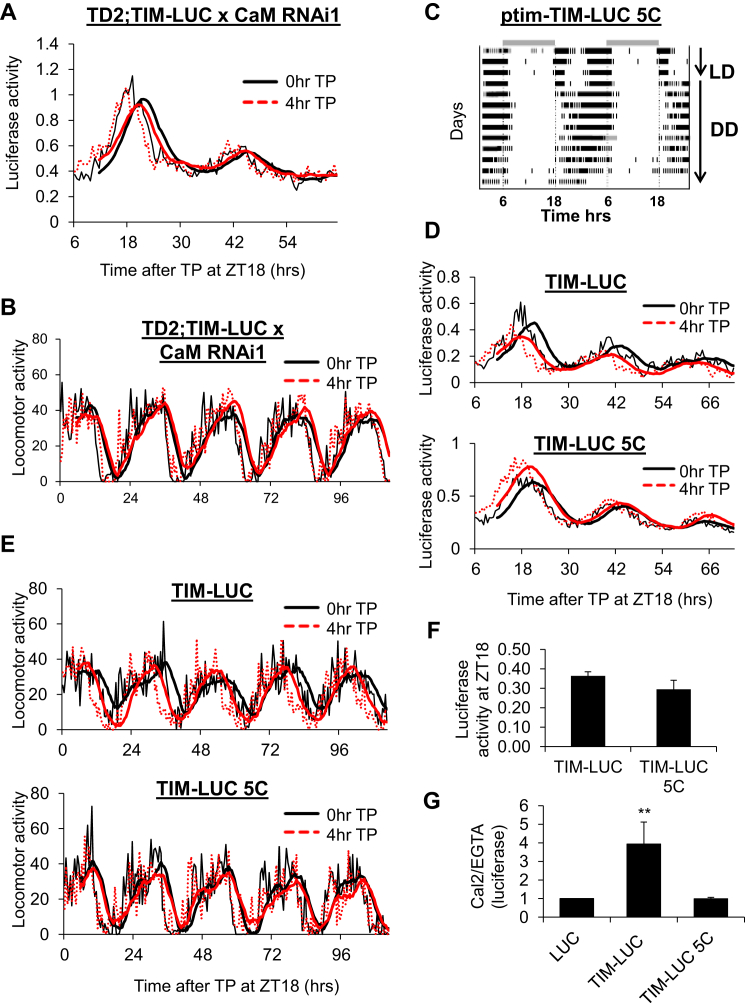
Thermal Degradation of TIM Is Mediated by CALMODULIN Binding, Related to Figure 3(A and B) CaM RNAi reduces phase-shifts induced by a 4 hr TP both in the periphery, as measured by luciferase activity (A) and in the brain, measured by locomotor behavior (B). See Figure S2A and S2C for controls from crosses to y w.(C) Flies expressing the TIM-LUC 5C mutant on a wild-type background free-run with normal period in constant darkness. Flies were entrained to a 12/12 LD cycle for three days and then released to constant darkness (DD). Locomotor activity of a single TIM-LUC 5C fly is shown.(D and E) Reductions in phase shifts were observed for TIM-LUC 5C mutant compared to its control, TIM-LUC. Flies were subjected to a 4 hr TP at ZT18 after three days of entrainment to a 12/12 LD cycle and luciferase (D) and locomotor behavior (E) was recorded.(F) Overall levels of TIM-LUC 5C was similar to TIM-LUC in all experiments. Average luciferase count from whole flies (n > 50) at ZT18 are shown.(G) TIM-LUC binds to CaM in a Ca2+ dependent manner in vivo, while TIM-LUC 5C mutant shows severely reduced binding. Whole head extracts (n = 80) from flies expressing wild-type TIM-LUC and 5C mutant were immunoprecipitated with CaM beads in the presence of CaCl2 or EGTA. Ca2+-dependent binding is shown as the ratio of luciferase signal in CaCl2 to EGTA. Error bars: SEM for (F) and (G). p < 0.01 from at least five independent experiments is indicated with “∗∗.”